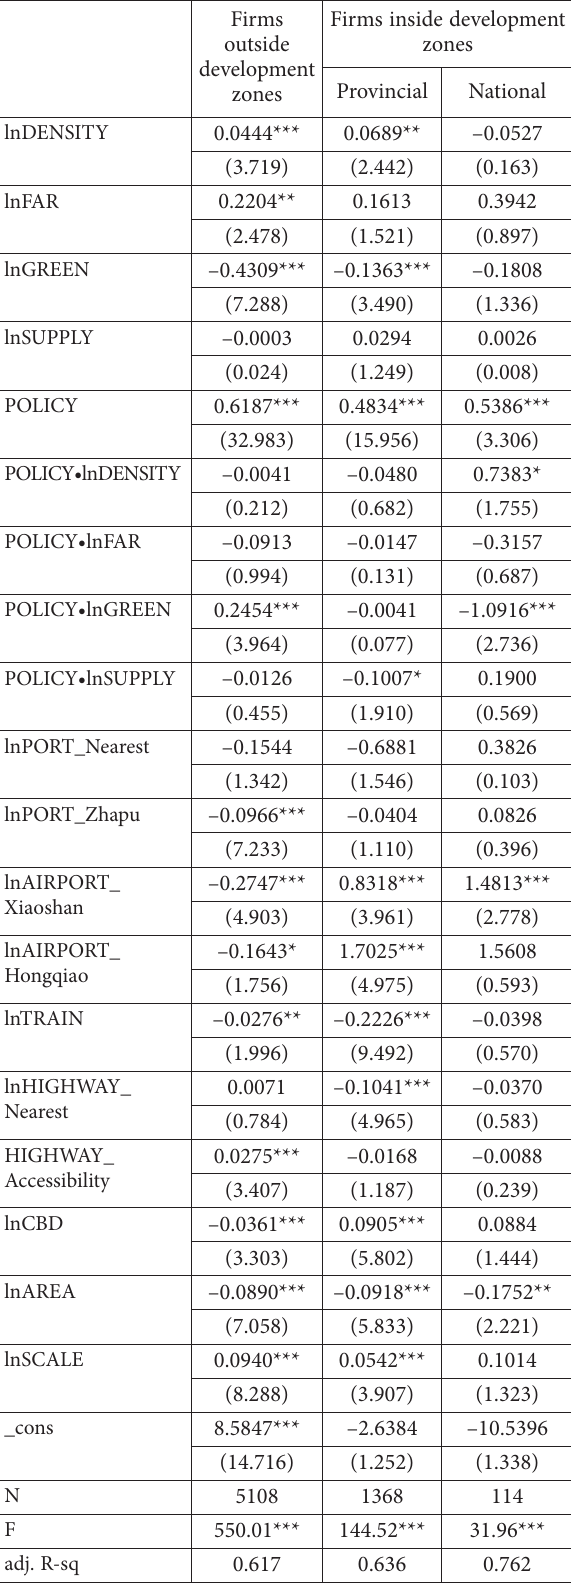
Table 5. Results of the regression model of the impact of land use regulation on industrial land price by development zone Firms outside development